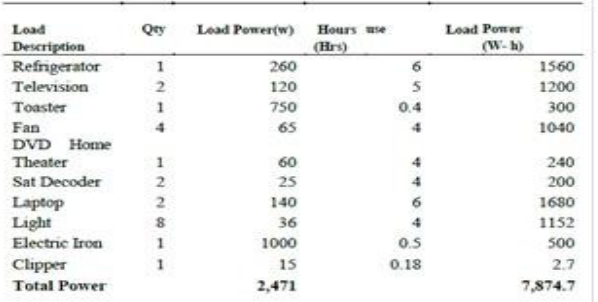
Table 1 - Electrical Load Demand for Residence :